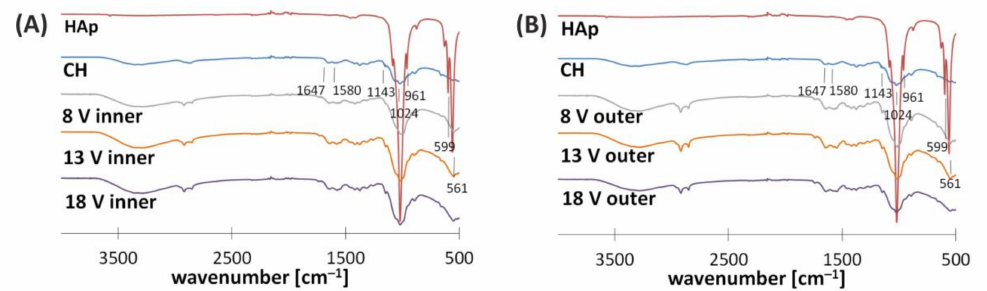
Figure 5. FTIR spectra of ( A ) the inner side and ( B ) outer side of hybrid implants obtained for the electrodeposition process initiated at different